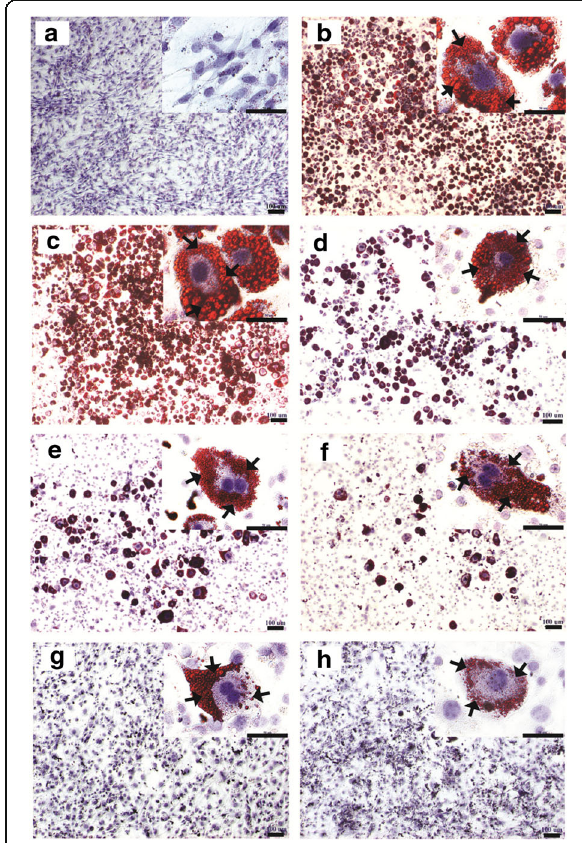
Fig. 4 Microscopic imaging of intracellular lipid after Oil Red O and heamatoxylin staining of the samples. 3T3-L1 cells are stained with Oil Red O and heamatoxilin. The lipid droplets were red in appearance and the nuclei were blue in colour. The arrows indicate lipid droplets within the adipocytes. The size and the number of lipid droplets appear to be a larger in untreated adipocytes ( b and c ). a non-differentiated cells (pre-adipocytes); b differentiated cells (untreated adipocytes); c vehicle control; d , e , f and g differentiated cells treated with Oroxylum indicum extract at the dose 50 μ g/mL, 100 μ g/mL, 150 and 200 μ g/mL, respectively; h simvastatin at 1.67 μ g/mL (original magnification at ×40, scale bar; 100 μ m and Inset view at × 400, scale bar; 50 μ